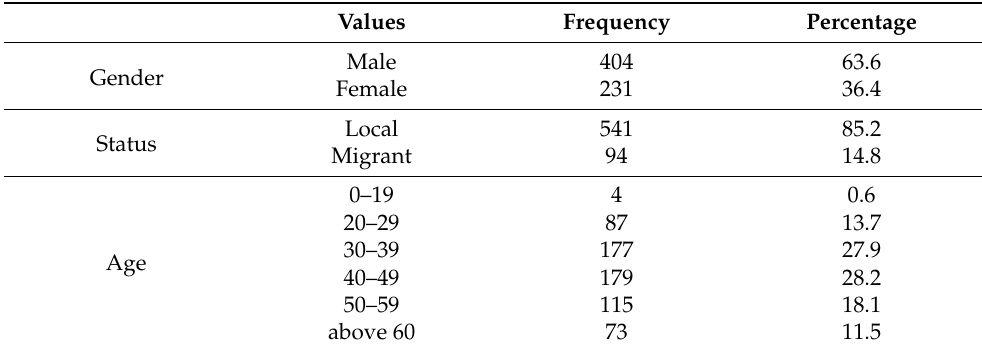
Table 2. Socio-demographic structure of the